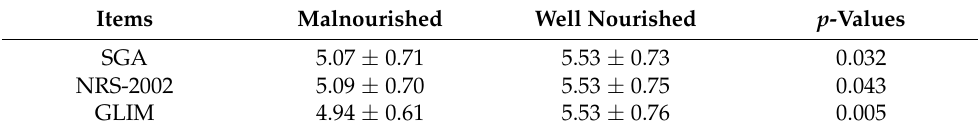
Table 3. Comparison of PhA values between the malnourished and well-nourished groups.